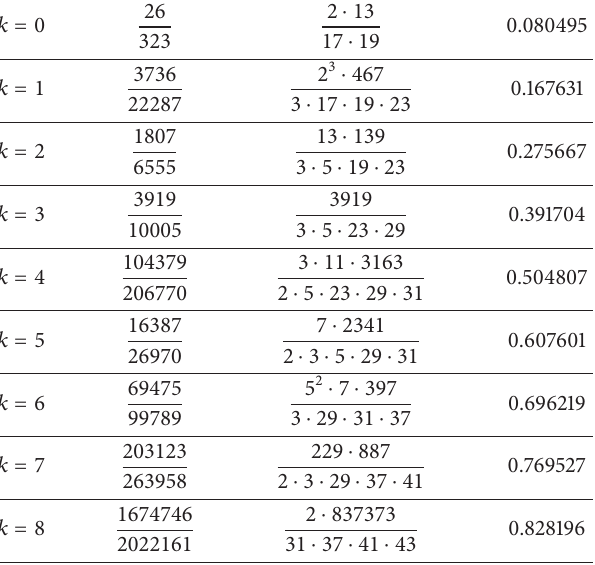
Table 3: Two-quaterbit ( 𝛼 = 2) separability probabilities.